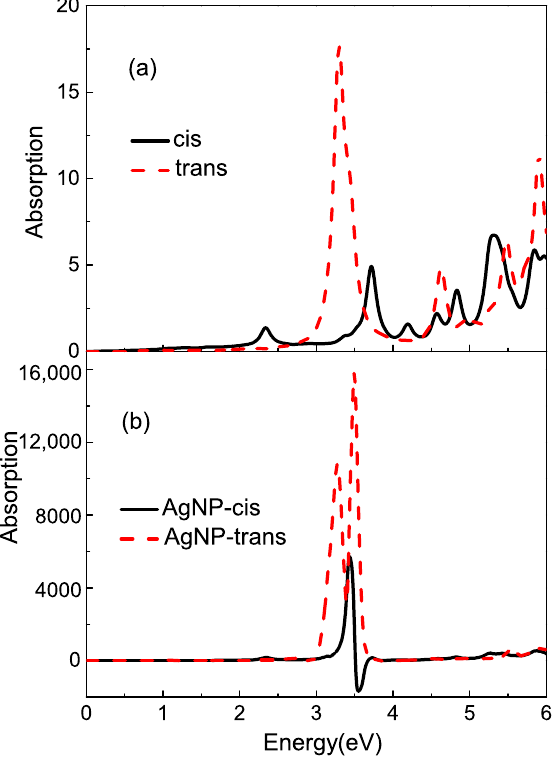
Figure 2. ( a ) The average absorption cross sections of isolated cis and trans azobenzene molecules in gas phase; ( b ) the average absorption cross sections of bound